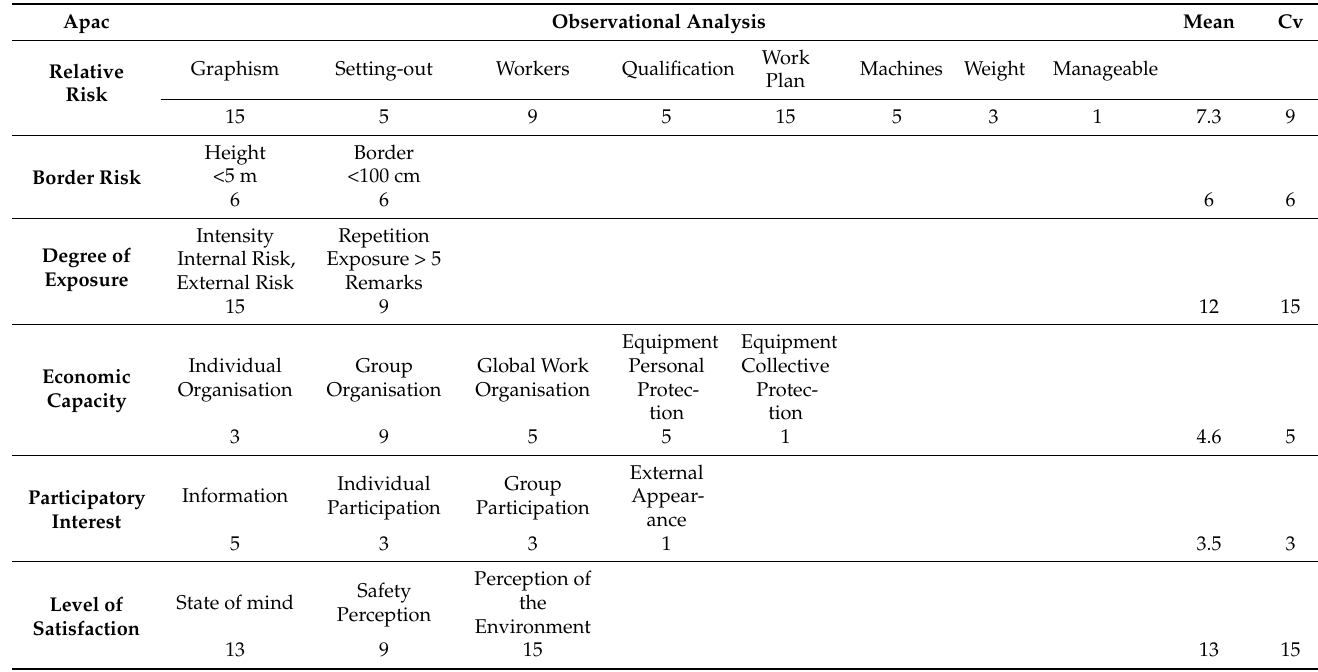
Table 6. Lpac assessment for the case